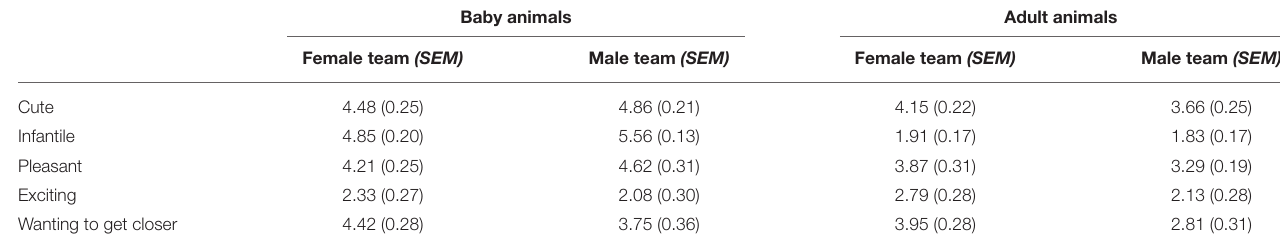
TABLE 1 | Mean subjective rating scores of photo images.